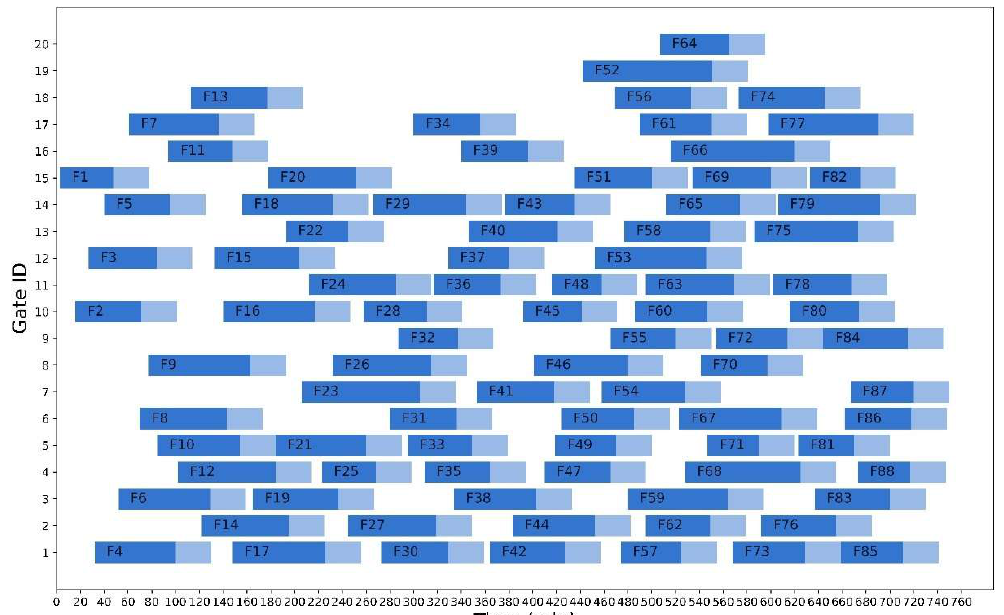
Figure 5. Gantt diagram for gate allocation results.